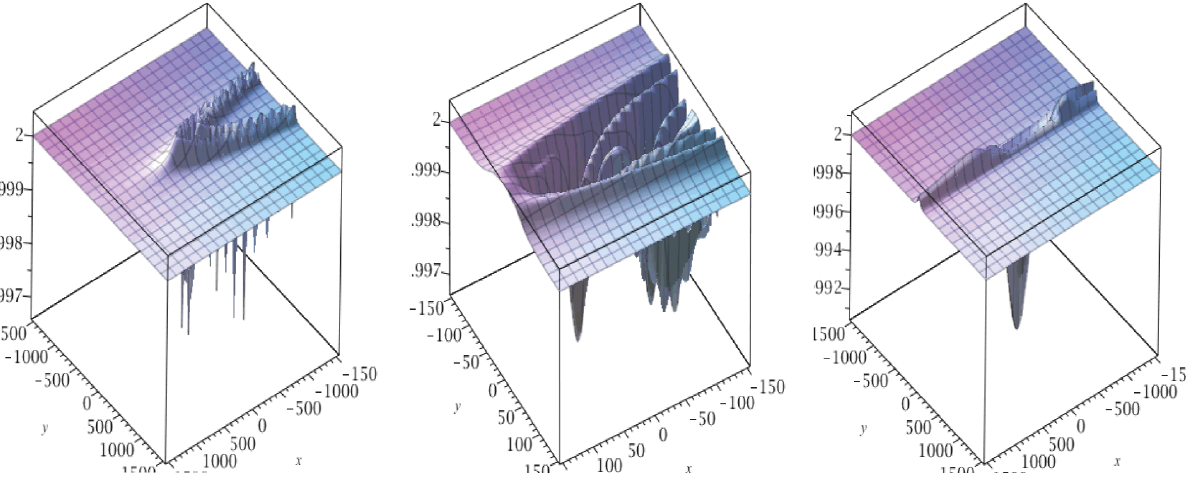
= 10 3 , 𝑏 = 0 , 𝑎 = 0 , and 𝑏 = 0 . 1 1 2 2